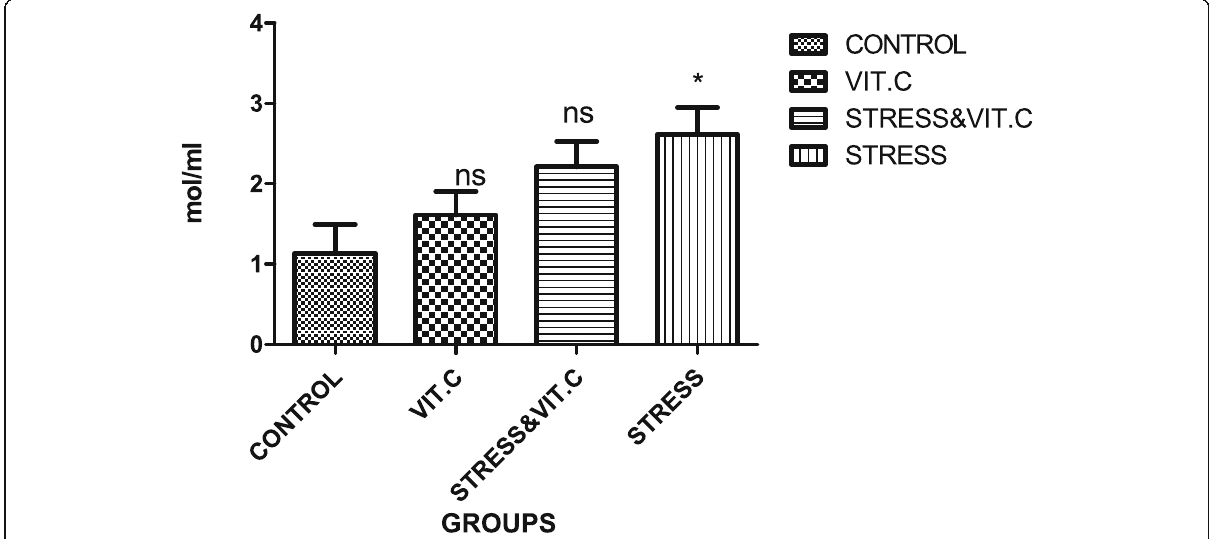
Fig. 5 Effect of chronic variable stress with vitamin C supplementation on serum malondialdehyde activity in Wistar rats. * p < 0.05when compared to control, ns no